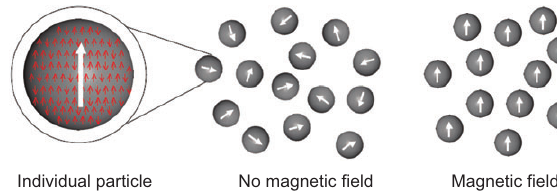
Figure 2 Schematic representation of a superparamagnetic